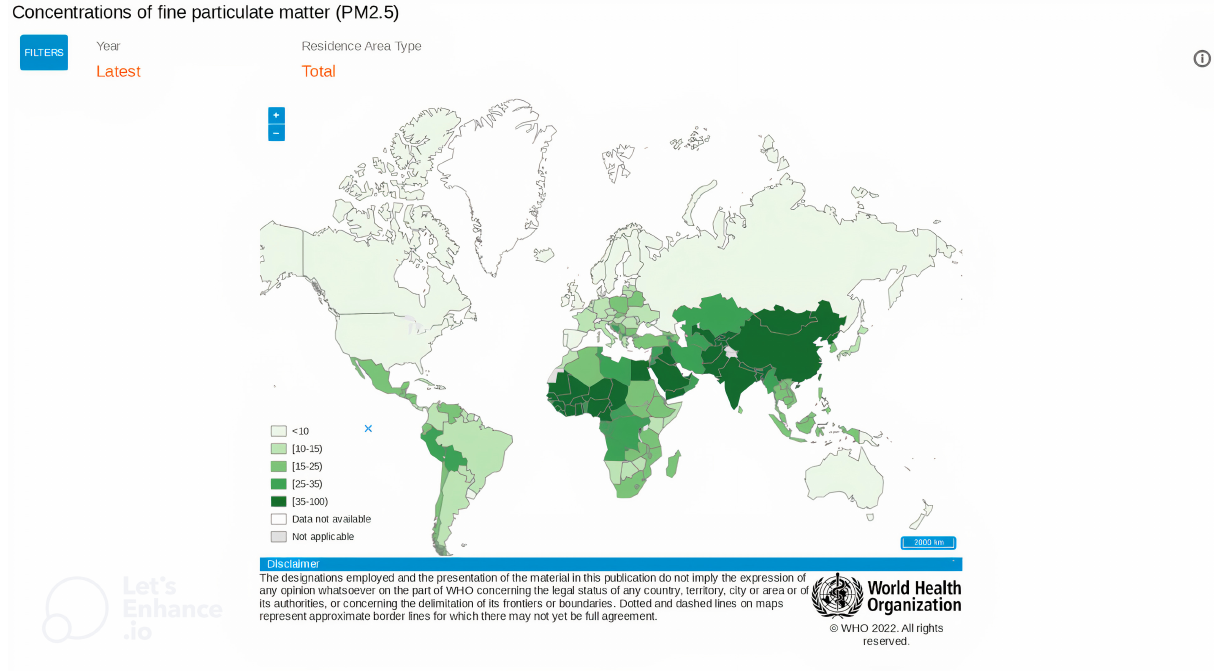
Figure 1. Geographic visualization representing the latest global distribution of annual mean levels of PM 2.5 concentrations ( µ g/m 3 ) in cities (population weighted) according to the WHO Air Quality Database